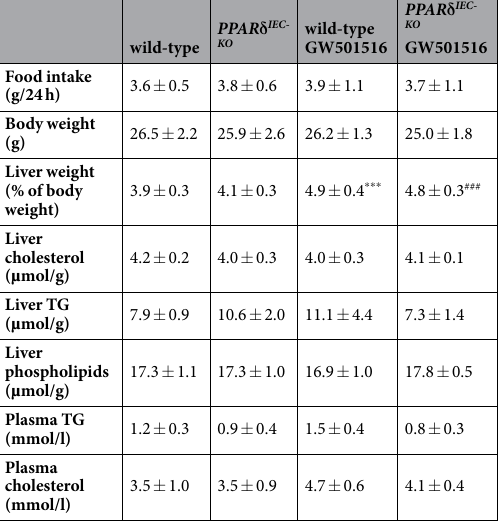
1.0 ± 1.3 to 2.9 ± 1.6 ( P < 0.05) as compared to wild-type littermates, respectively (Fig. 2C–E, Supplementary Fig. 2A,B, Supplementary Table 2). PPAR δ IEC-KO mice on a HFD displayed significantly increased levels of fasting plasma insulin and increased insulin resistance as compared to their wild-type littermates (Fig. 2G,H,J). Fasting plasma glucose levels and oral glucose tolerance on the other hand were not different (Fig. 2F,I). In addition, no differences were observed in food intake, respiratory exchange rate (RER), activity (Table 2, Supplementary Fig. 2C,D) and microbiota in the distal part of the small intestine (data not shown). PPAR δ IEC-KO mice challenged with a HFD displayed increased plasma levels of total cholesterol (Table 2). Further analysis by fast protein liquid chromatography (FPLC) confirmed increased levels of total cholesterol in PPAR δ IEC-KO mice and showed that this was mainly due to higher levels of LDLc. This difference in lipoprotein pro- file was not seen on a control LFD (Fig. 3A,B). Levels of proglucagon mRNA in the distal small intestine were sig- nificantly increased by a HFD in wild-type mice but not in PPAR δ IEC-KO mice. However, this difference in mRNA did not result in reduced plasma levels of GLP-1 in PPAR δ IEC-KO mice at 30 min after a glucose bolus (Fig. 3C,D). Also, no changes in the expression of genes involved in cholesterol transport and the pro-inflammatory cytokine TNF α were observed in the distal small intestine of PPAR δ IEC-KO mice and wild-type littermates challenged with a HFD (Fig. 3E,F). Together, these results show that intestinal PPAR δ protects against HFD induced obesity, insulin resistance and dyslipidemia.